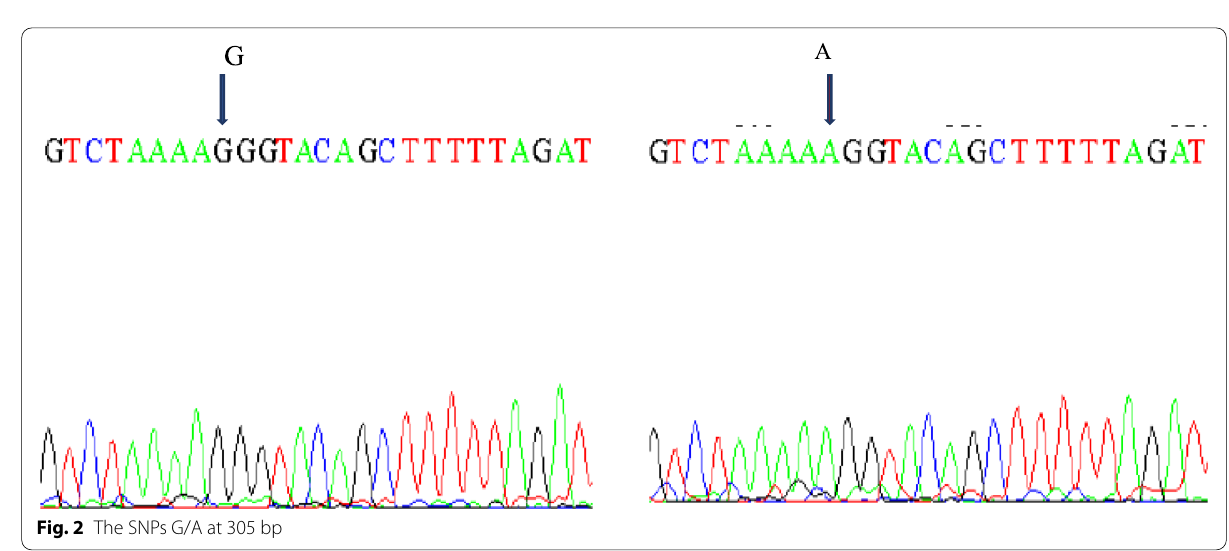
Fig. 2 The SNPs G/A at 305